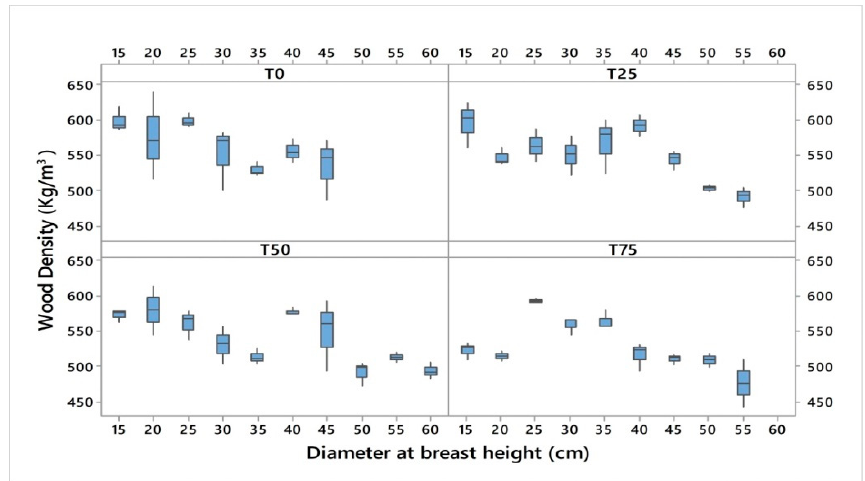
Figure 2. Variability of the tree wood density for each treatment as shared by diameter classes.